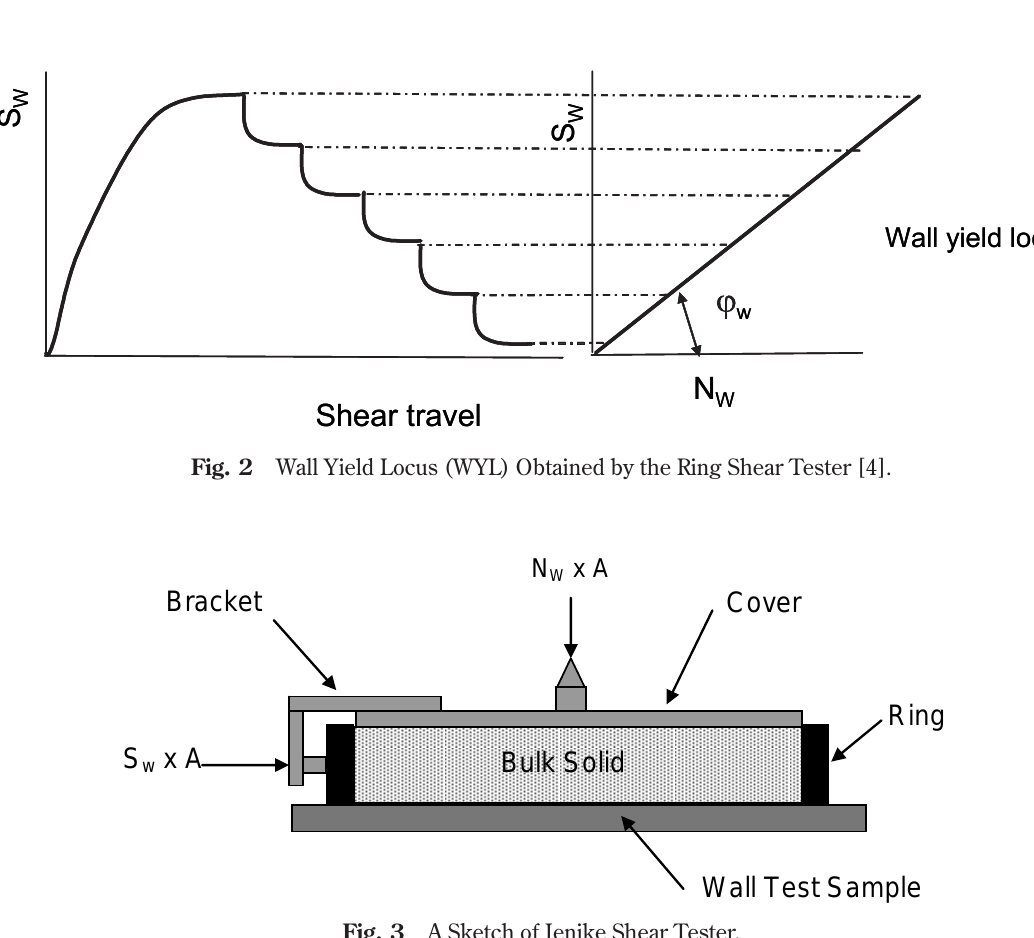
Fig. 3 A Sketch of Jenike Shear